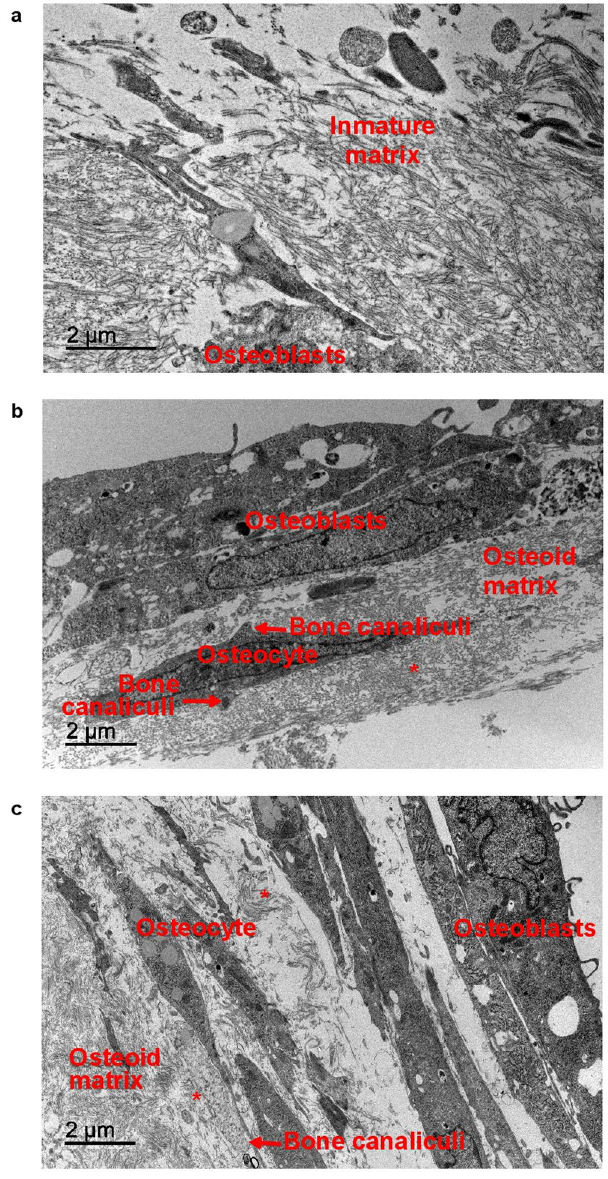
Figure 6. Rat bone marrow MSC differentiated into osteoblasts displayed phenotypic characteristics of osteocyte with MgCl 2 supplementation. Pictures show TEM images of a MSC after 21 days of osteogenic stimuli with Mg 2 + 0.8 mM, b 1.2 mM and c 1.8 mM. Scale bar 5 µ m. * Collagen fibers; Arrows: Bone